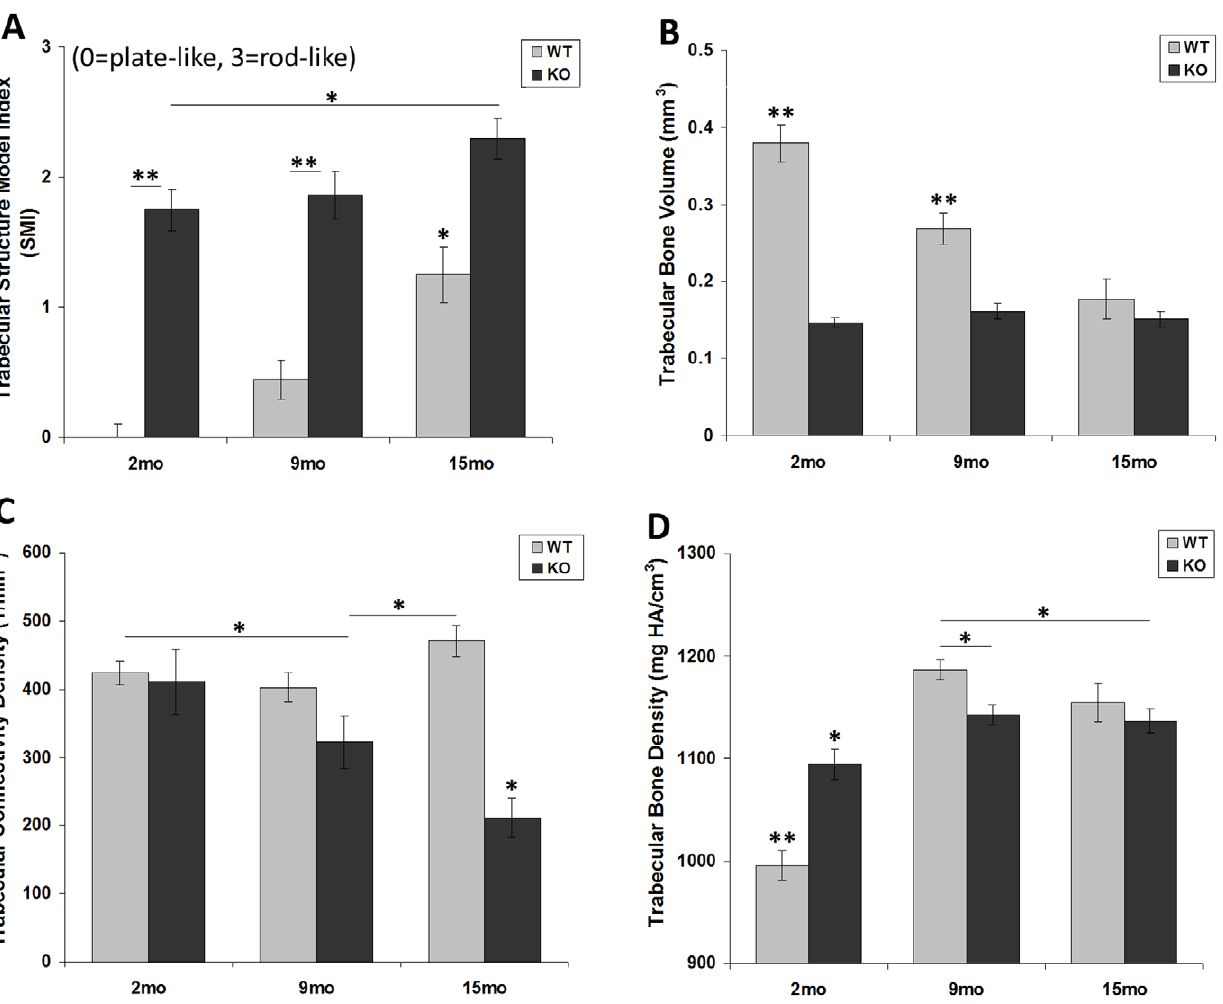
Figure 2. MicroCT measures of trabecular bone structure. In the tibial epiphysis of collagen VI null mice ( Col6a1 2 / 2 ), the structure model index (SMI, A) shows evidence of rod-like trabeculae from the earliest age, in contrast to the initially plate-like trabeculae of the wild-type mice. The trabecular bone volume (BV, B) is low from an early age and contributes to a higher bone tissue density (BD, D) in 2-month-old Col6a1 2 / 2 mice. With increasing age, the Col6a1 2 / 2 connectivity density (ConnDens, C) drops significantly at 15 months. Bars are mean 6 SEM. Starred bars with no connecting lines are different from all other bars including each other. Horizontal lines connect statistically significantly different values. * p , 0.05; ** p , 0.01. WT= Col6a1 + / + ; KO= Col6a1 2 / 2